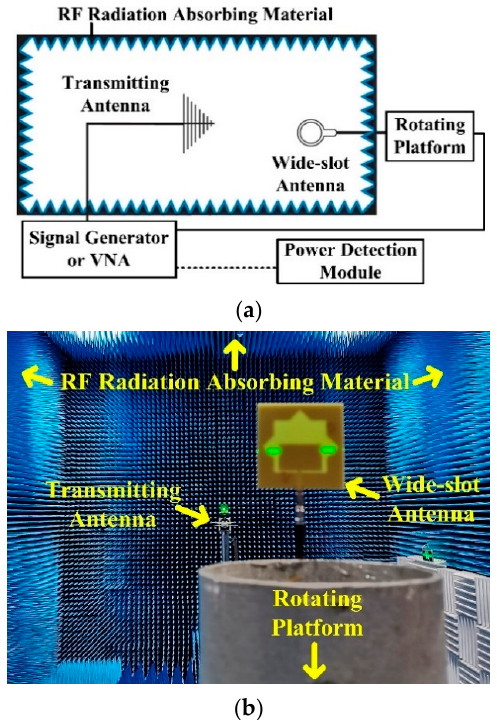
Figure 7. Measurement Environment. ( a ) Connection frame; ( b ) Photo of the environment.